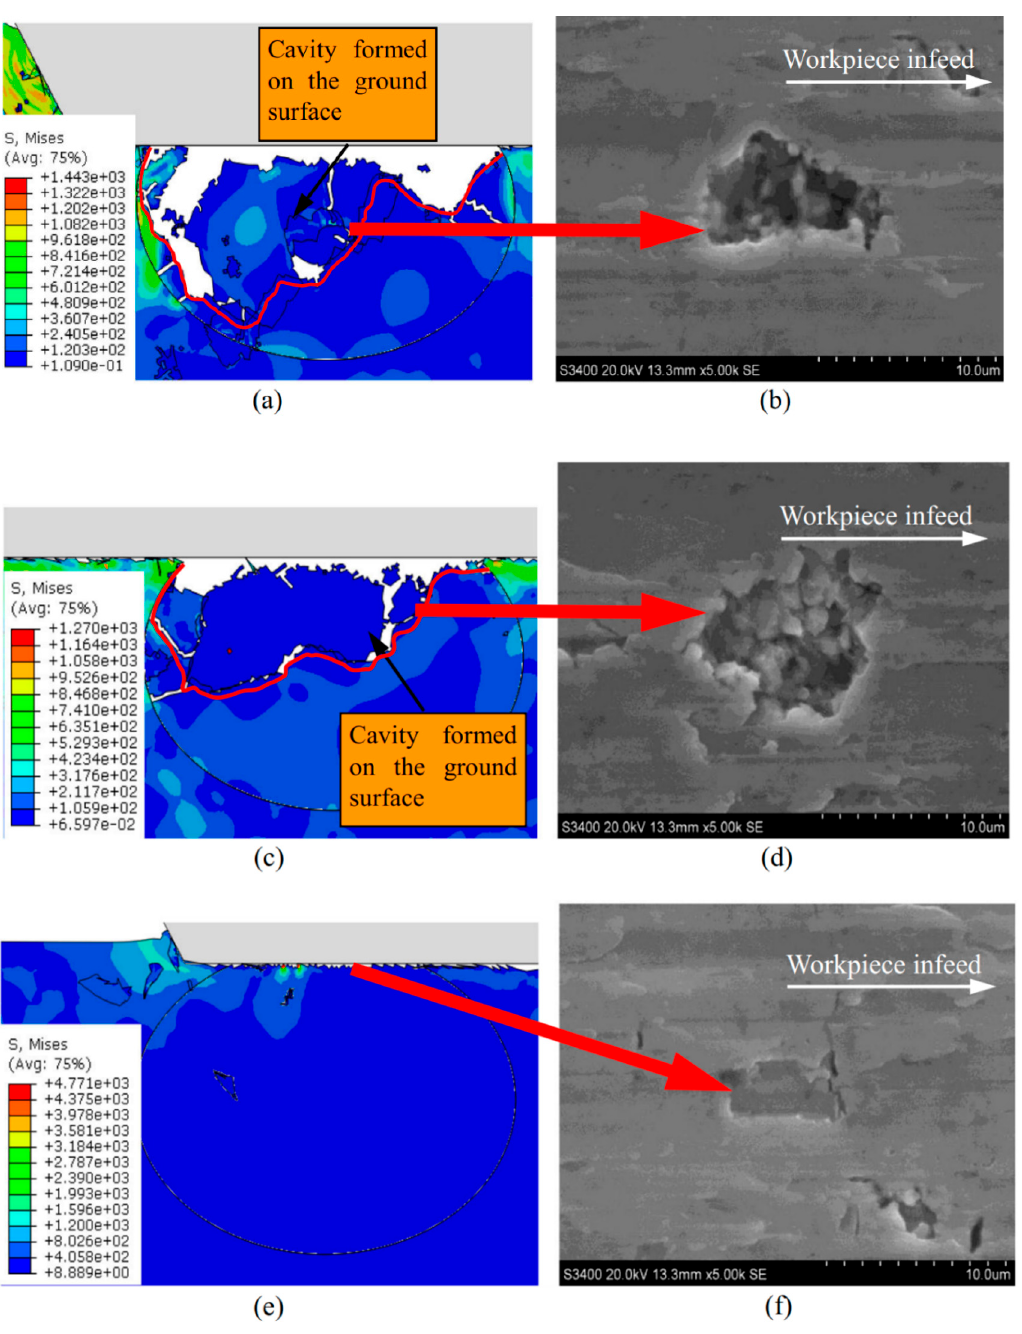
Figure 10. Effect of undeformed chip thickness on ground surface. Experiment versus simulation. ( a ) and ( b ) a p = 1.2 µM, ( c ) and ( d ) a p = 0.7 µM, and ( e ) and ( f ) a p = 0.2 µM [65].